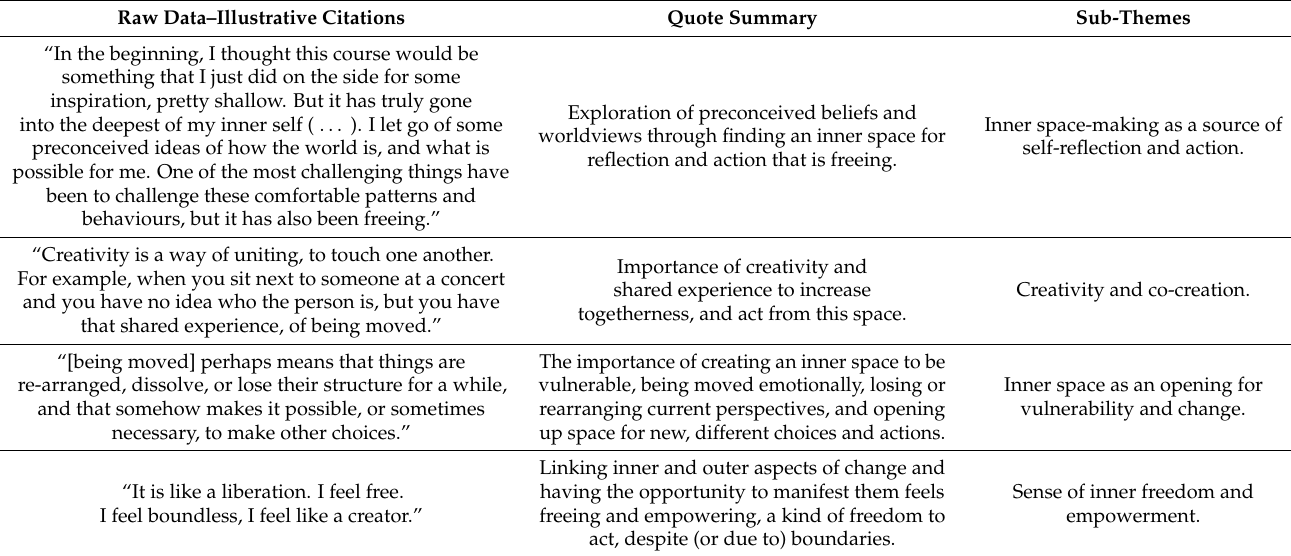
Table 2. Theme 2–Inner space-making, freedom and